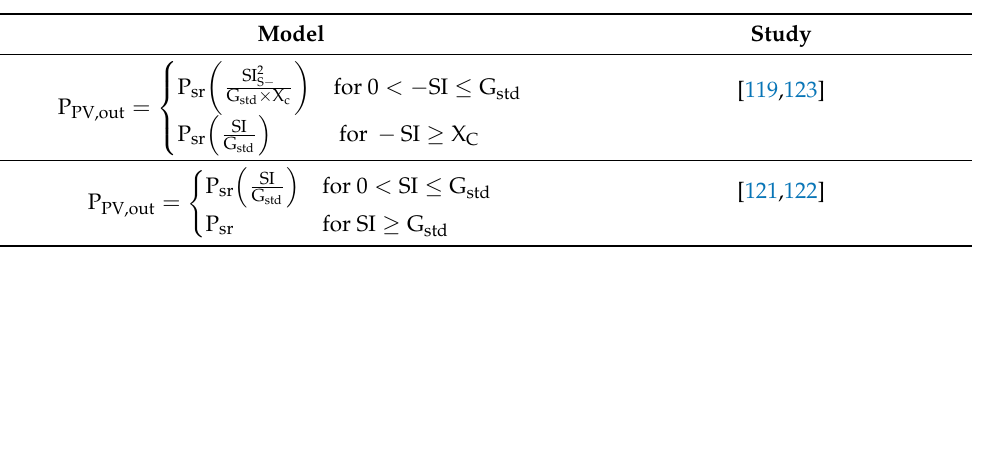
Table 5. Models for Determining PV Power